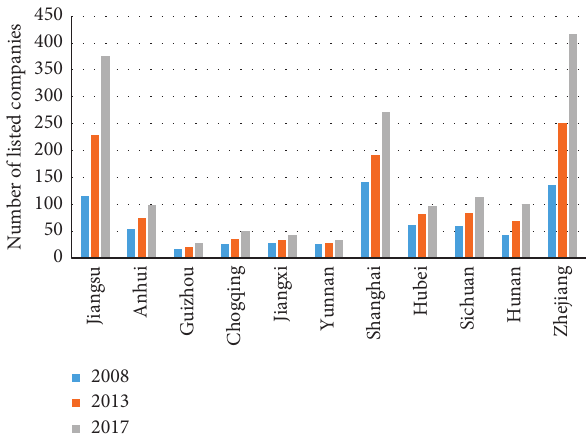
Figure 3: The distribution of listed companies in the provinces of the YEB region in 2008, 2013, and